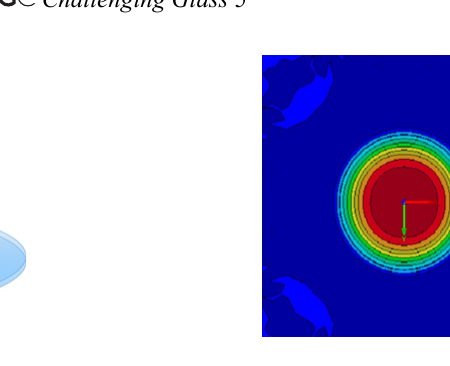
Fig. 5 Pressure pat on ring test set-up, distribution of principle stress.